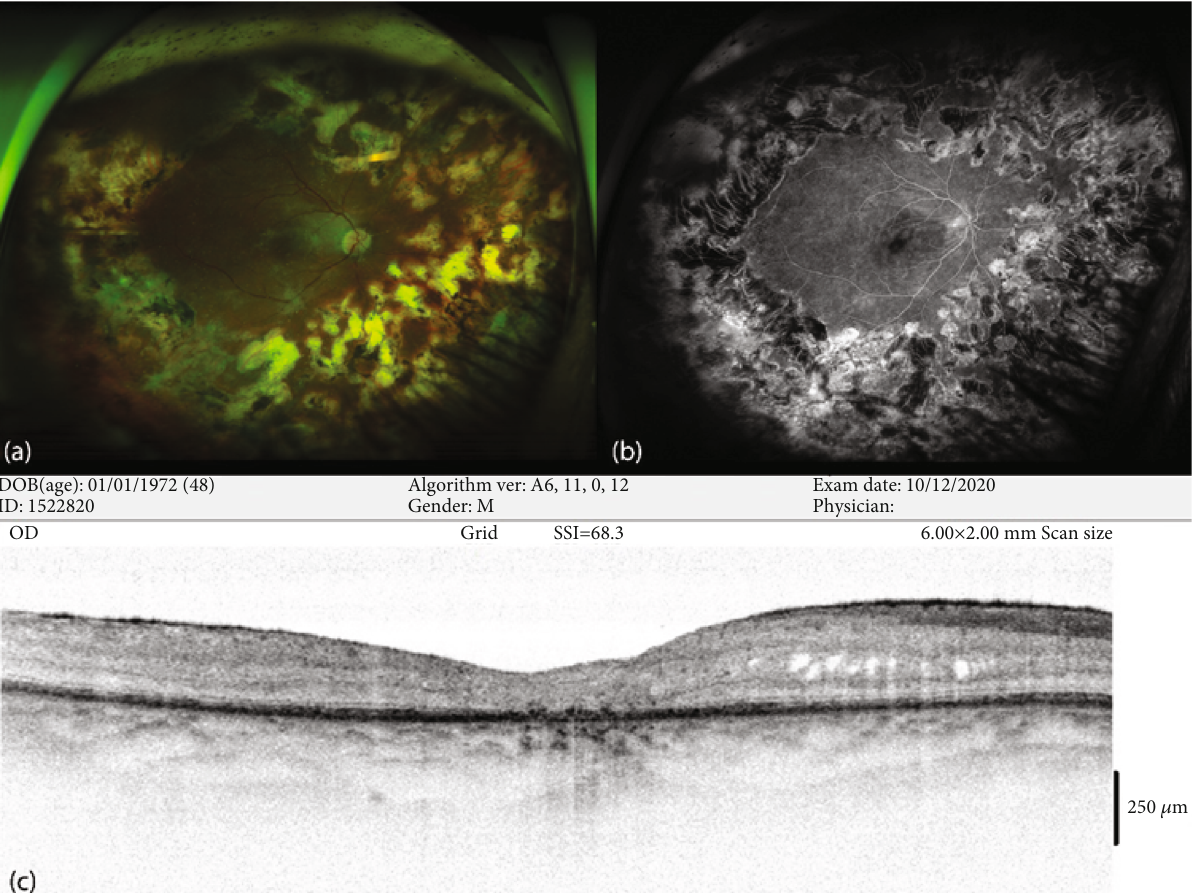
Figure 5: Right eye fi ndings after 4.5 years: (a) wide-angle fundus photograph (Optos PLC, Dunfermline, UK), (b) fundus fl uorescein angiography late phase image (Optos PLC, Dunfermline, UK), and (c) macular OCT image (Optovue RTVue, RT 100, software version 6.3, Optovue, CA, USA), atrophy in the outer retinal layers, irregularity in the ellipsoid zone, cystoid macular edema, and epiretinal